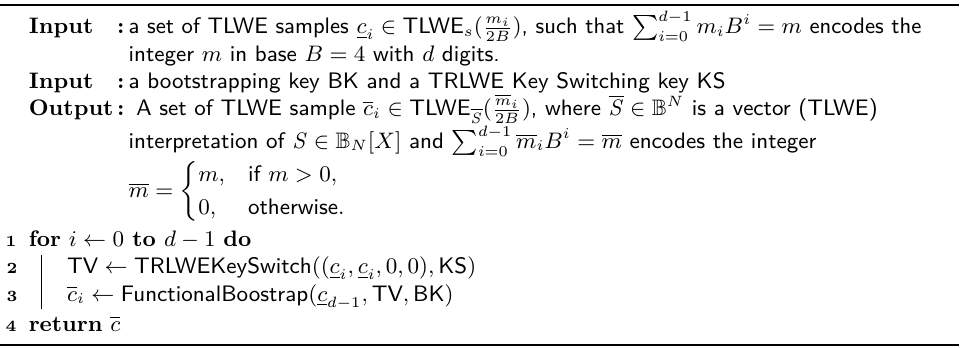
Algorithm 10: ReLU implementation using the tree-based method.